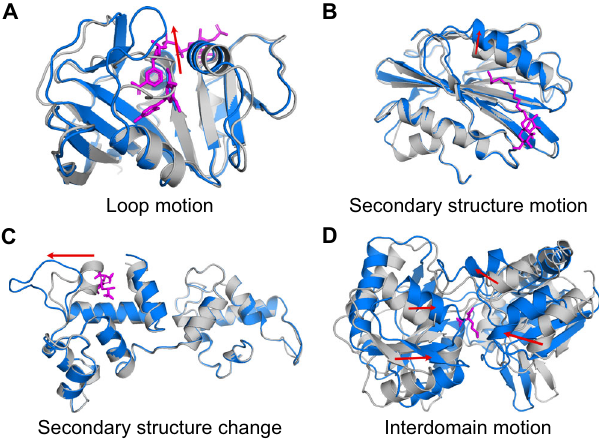
Fig. 4 | PocketMiner ’ s validation dataset contains diverse types of conforma- tional changes that lead to cryptic pocket formation. Apo structures are shown in gray, holo structures are shown in blue, and ligands are shown in magenta. The red arrows highlight the main conformational change occurring between apo and holo . A Cryptic pockets can arise as a result of loop motions like those seen in dihydrofolate reductase (apo PDB: 2W9T 74 , holo PDB: 2W9S 74 ); ( B ) secondary structure element motions such as those seen in lipoprotein LpqN (apo PDB: 6E5D 75 , holo PDB: 6E5F 75 ); ( C ) secondary structure changes like those observed in calcium- and integrin-binding protein 1 (apo PDB: 1Y1A chain A 76 , holo PDB: 1Y1A chain B); ( D ) or interdomain motions as in nopaline-binding periplasmic protein (apo PDB: 4P0I 77 , holo PDB: 5OTA 78 ). We refer to examples like those shown in A – C as forward pockets because the residues adjacent to the ligand in the holo structureare farther from one another thanthey are inthe apo structure. We refer to examples like that in D as reverse pockets because the residues adjacent to the ligand in holo are closer together than they are in apo